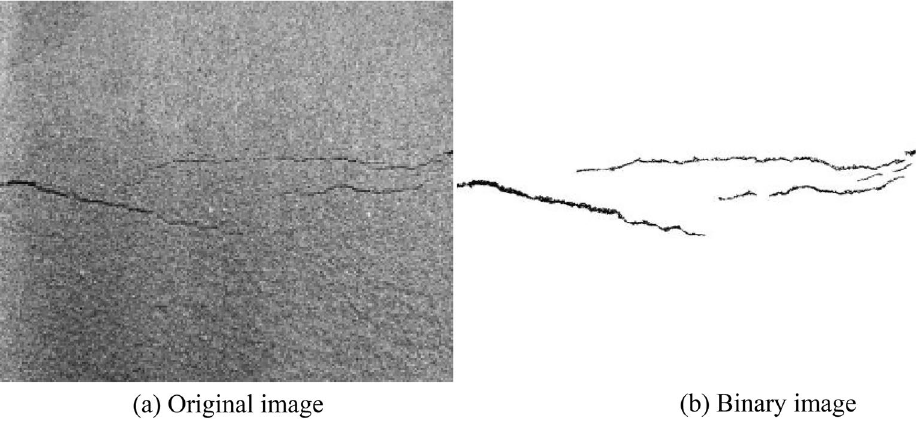
Figure 4. Binarization of tailing sand fracture